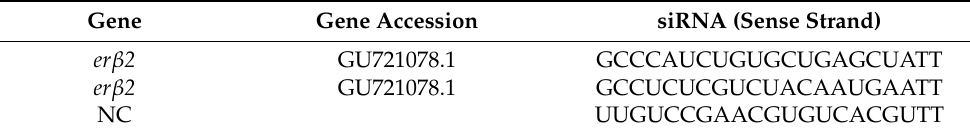
Table 1. siRNA used in knockdown